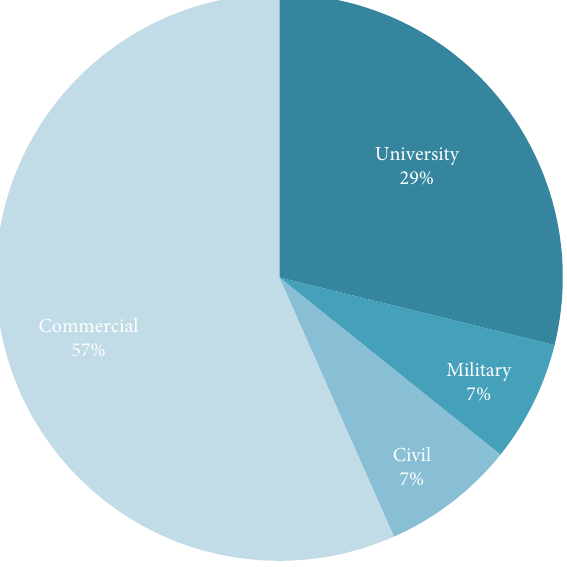
Figure 6: Distribution of CubeSats by end user.